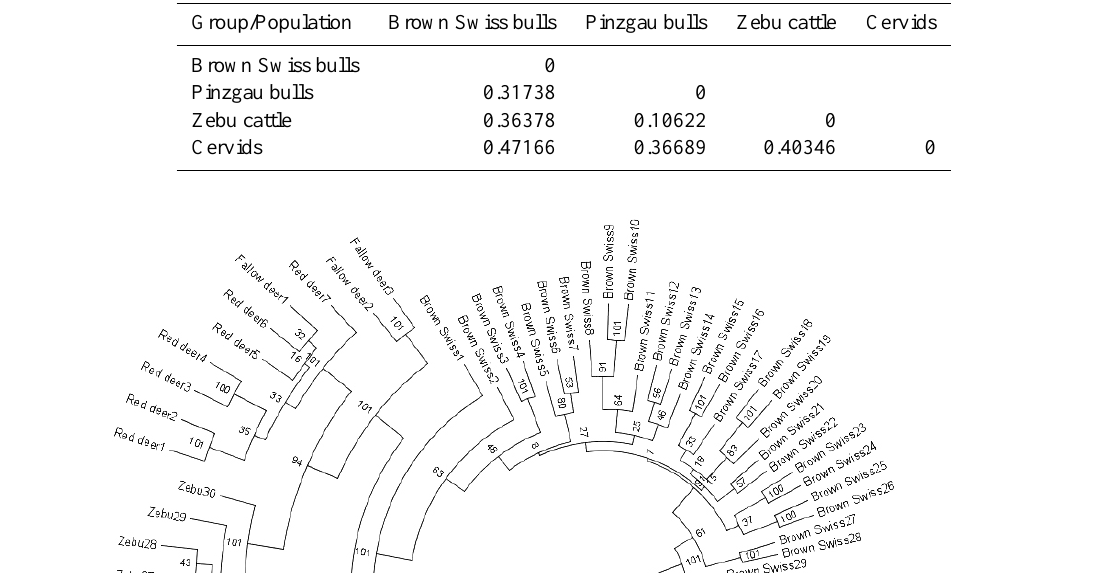
average genetic distances between pairs of individuals from the same analysed groups was lowest between Pinzgau and Brown Swiss